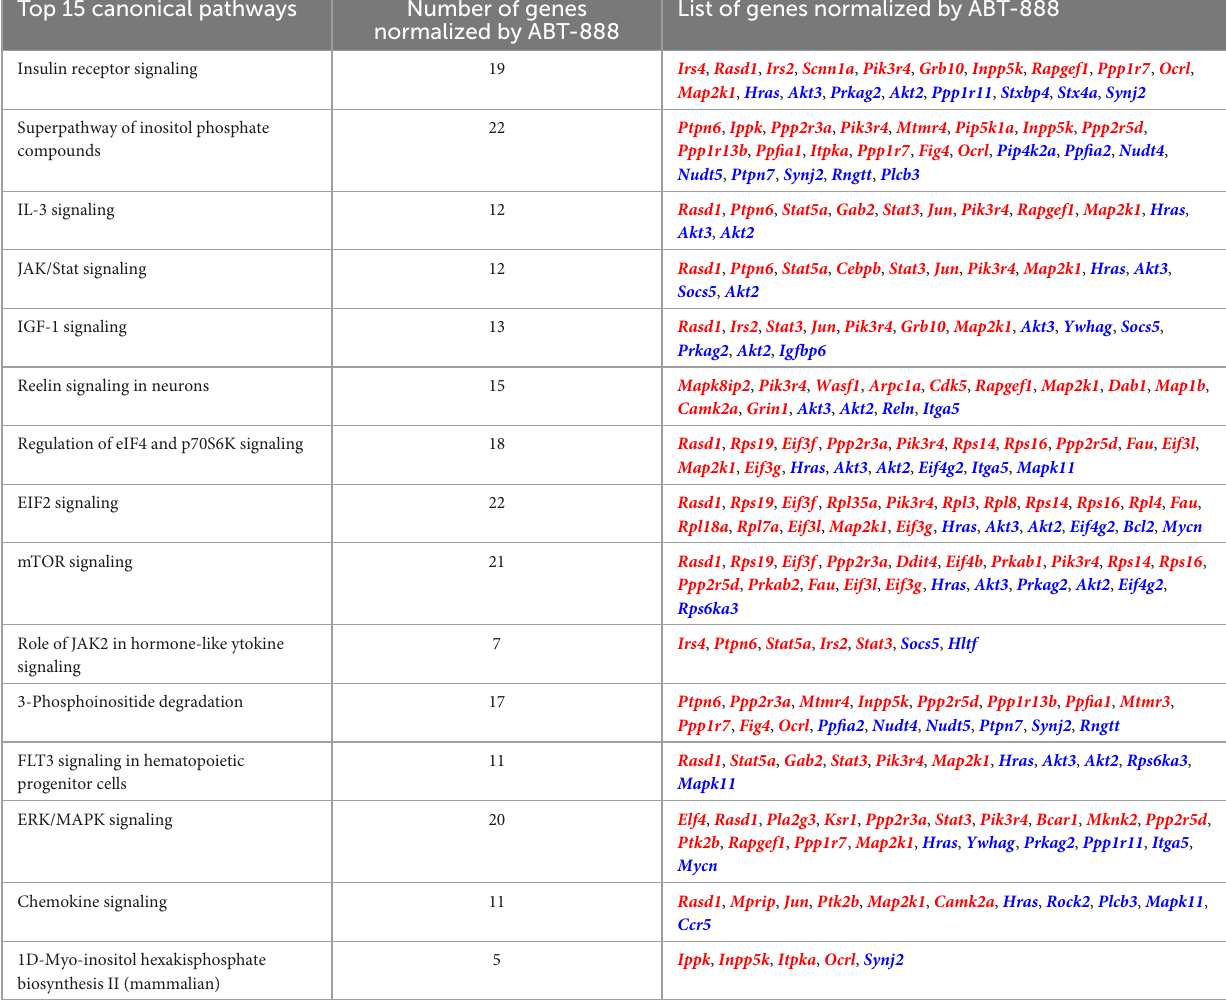
TABLE 2 Top 15 canonical pathways predicted by IPA emerging from the 1,115 transcripts that are reversed with ABT-888. Top 15 canonical pathways Number of genes List of genes normalized by normalized by ABT-888